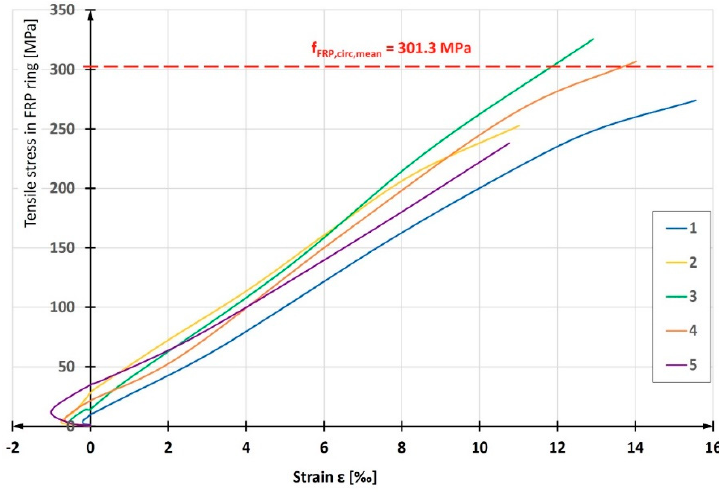
Figure 10. Tensile σ - ε relationships in circumferential direction, obtained for fiber reinforced polymer (FRP) ring samples of pipe with winding angle θ = 55°.